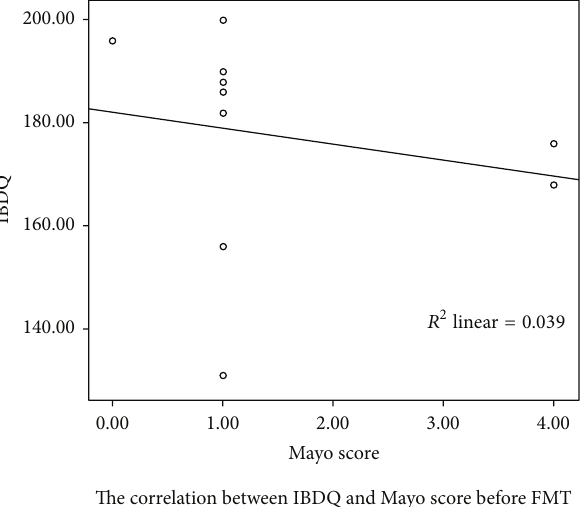
The correlation between IBDQ and Mayo score before FMT